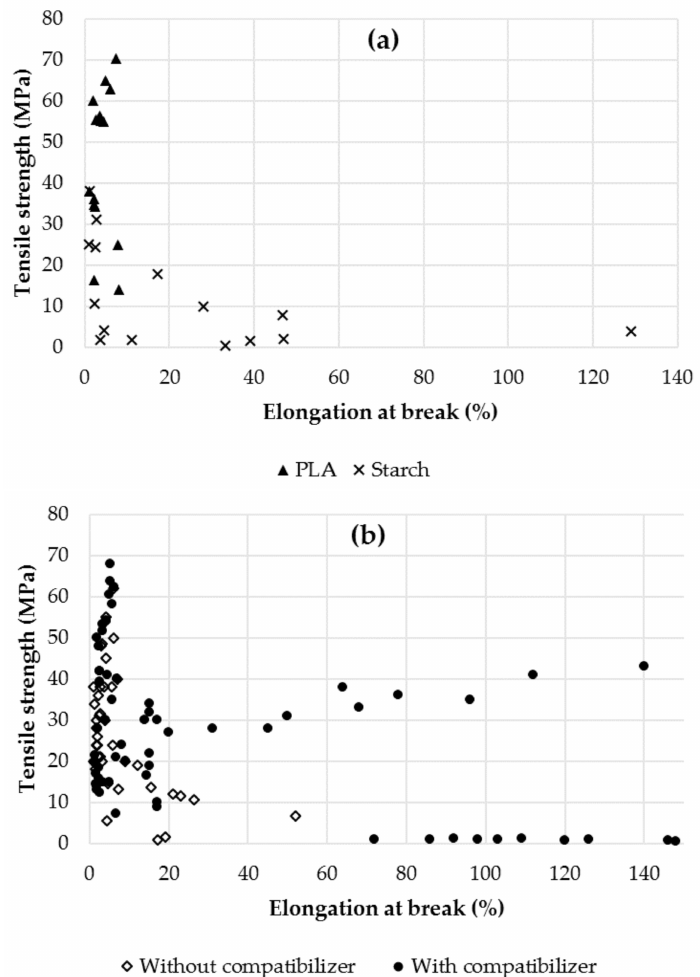
Figure 5. Map of tensile properties of neat PLA and starch ( a ); and of PLA-starch blends without and with compatibilizer ( b